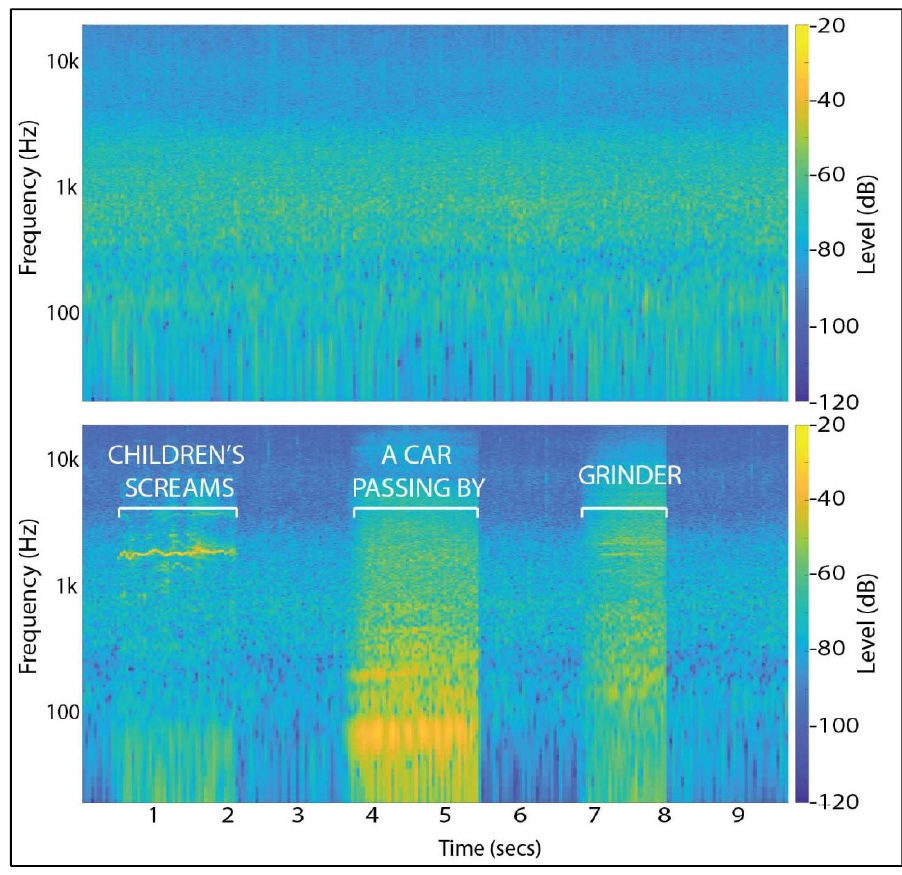
Figure 3. The spectrogram of the stream (top picture) and the spectrogram of the stream with the inserted distracting short signals (bottom picture).